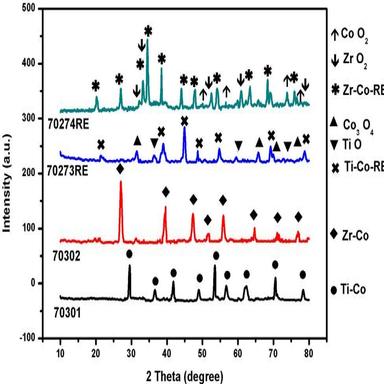
X-ray diffraction (XRD) patterns of all four getter alloys.